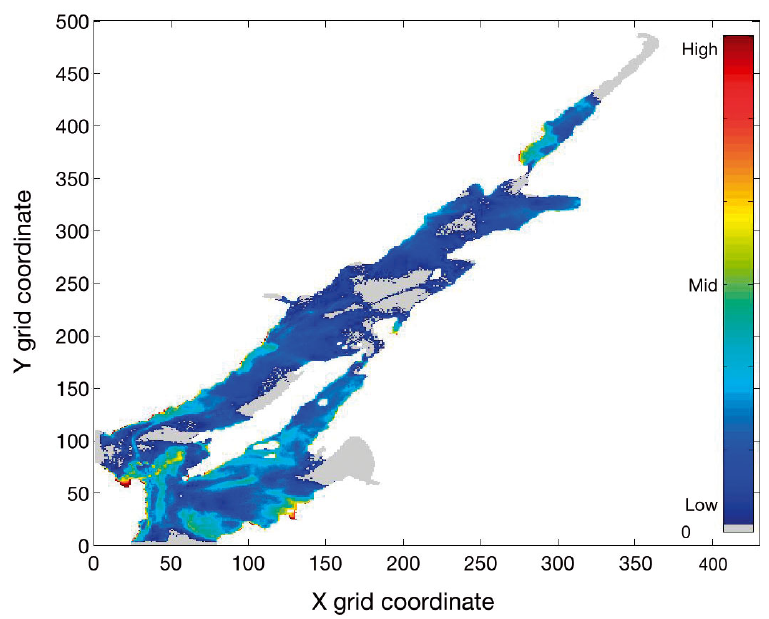
Fig. 4. Unvalidated results of Loch Linnhe particle dispersal showing high and low regions of particle